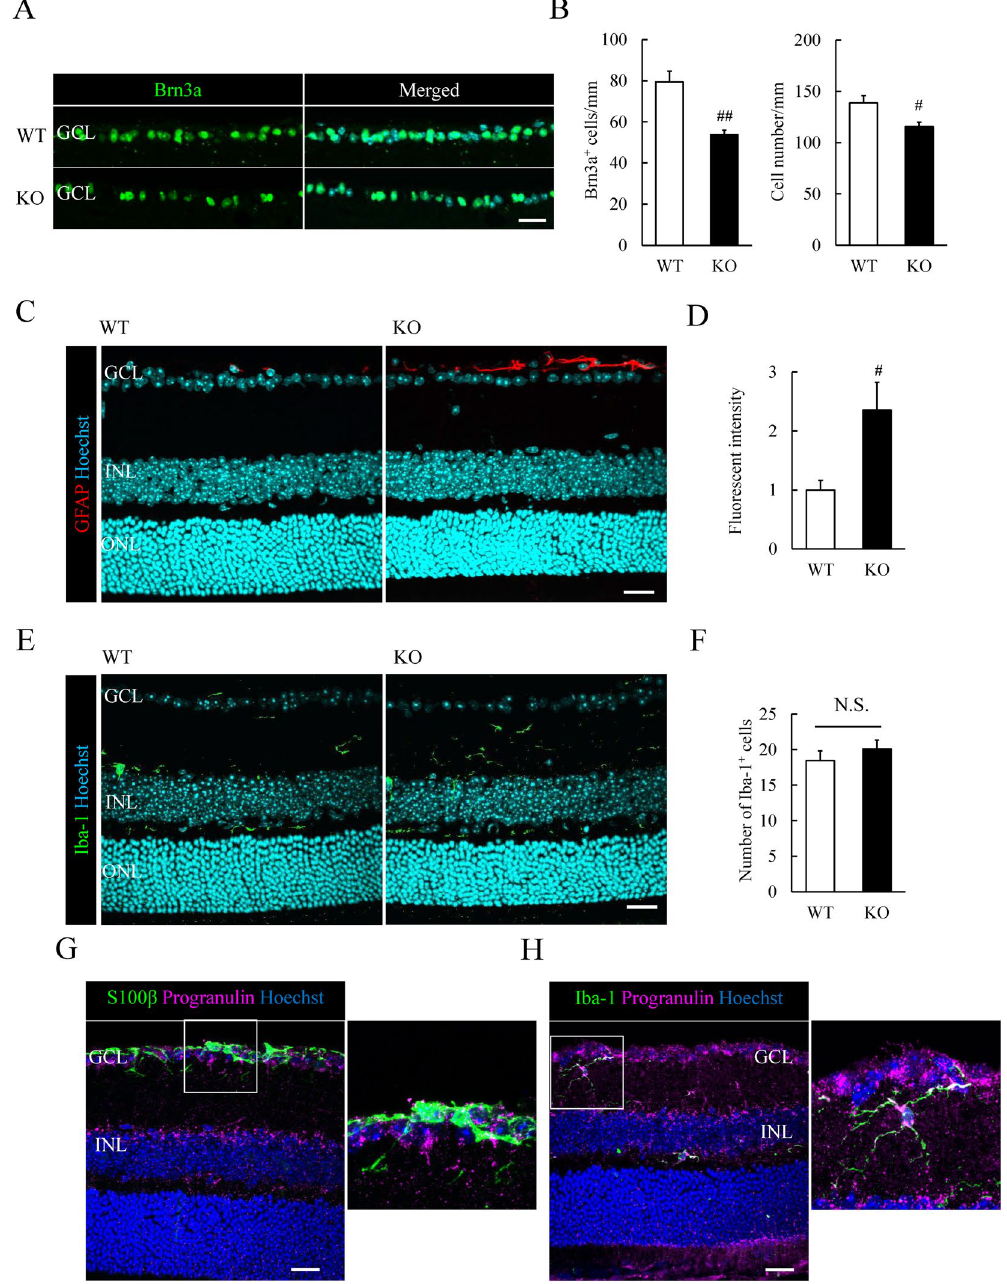
Figure 1. Decrease of Brn3a + retinal ganglion cells (RGCs) and high GFAP expression in adult Grn − / − mice. ( A ) Brn3a staining (green) shows the RGCs in the ganglion cell layer (GCL) of wild-type (WT) and progranulin-knockout (KO) mice. Nuclei are seen as cyan by Hoechst 33342 staining. ( B ) Number of Brn3a + cells and the number of cells in the GCL. The number of Brn3a + cells and the cells in the GCL are reduced in Grn − / − mice. ( C , D ) Representative images show the activated astrocyte (red by GFAP expression) in WT and Grn − / − mice. The fluorescent intensity is increased in Grn − / − mice. ( E , F ) Number of Iba-1 + microglia (green) is not changed in Grn − / − mice. ( G , H ) Progranulin expression (magenta) is observed around the S100 β + astrocytes (green) and co-localized with Iba-1 + microglia (green). Data are the means ± S.E.M. ( n = 4 or 5). ## P < 0.01, # P < 0.05 vs. WT (Student’s t -test). WT: wild-type; KO: knock-out. Scale bar = 20 μ